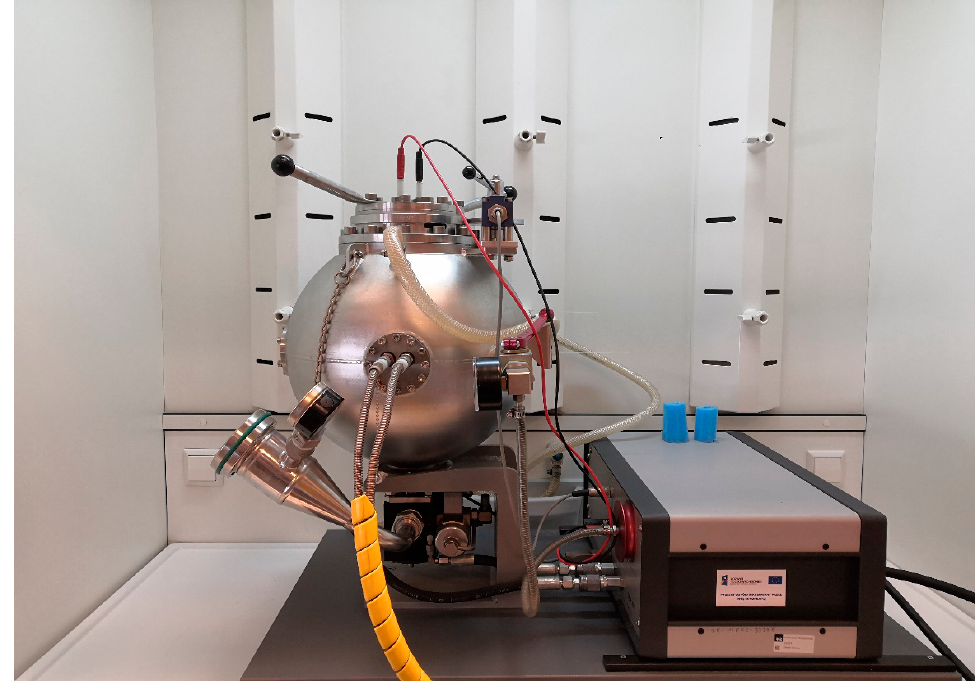
Figure 3. Explosivity Analyzer KSEP 310.